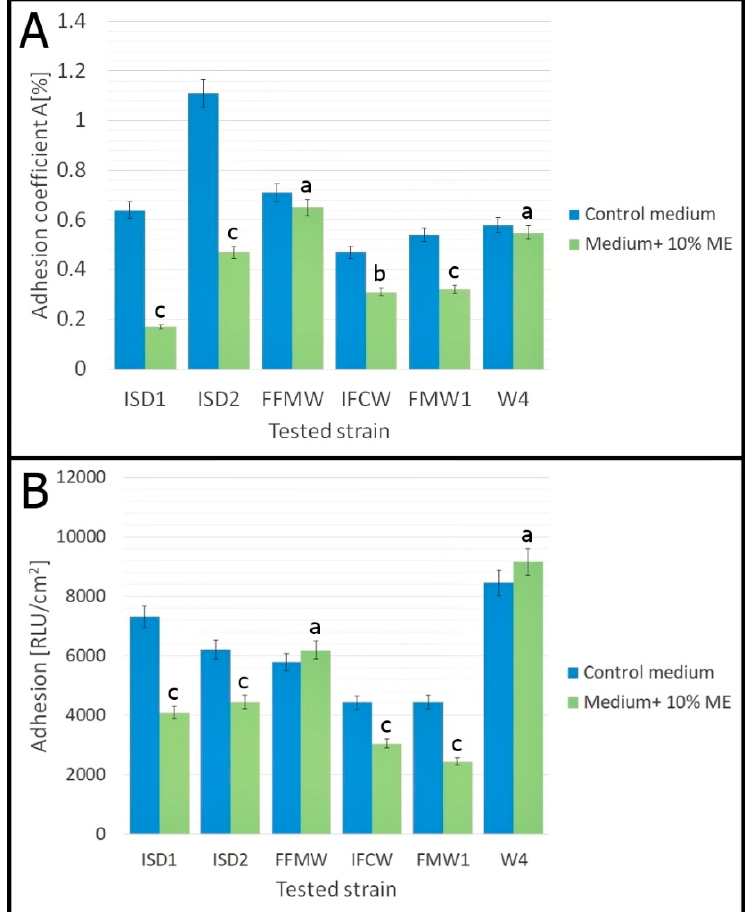
Figure 2. The effect of 10% ( v / v ) M. piperita L. mint extract (ME) on the adhesion of As. bogorensis (ISD1, ISD2, FFMW) and As. lannensis (IFCW, FMW1, W4). ( A ) Results of the plate count method. ( B ) Results of the luminometric method. Results obtained for control samples (without mint extract) were compared with results for samples with 10% ( v / v ) mint extract using one-way repeated measures analysis of variance (ANOVA). The values with different letters are statistically different ( p < 0.05). a— p ≥ 0.05; b—0.005 < p < 0.05; c— p < 0.005. The results were compared with data received for the control medium.